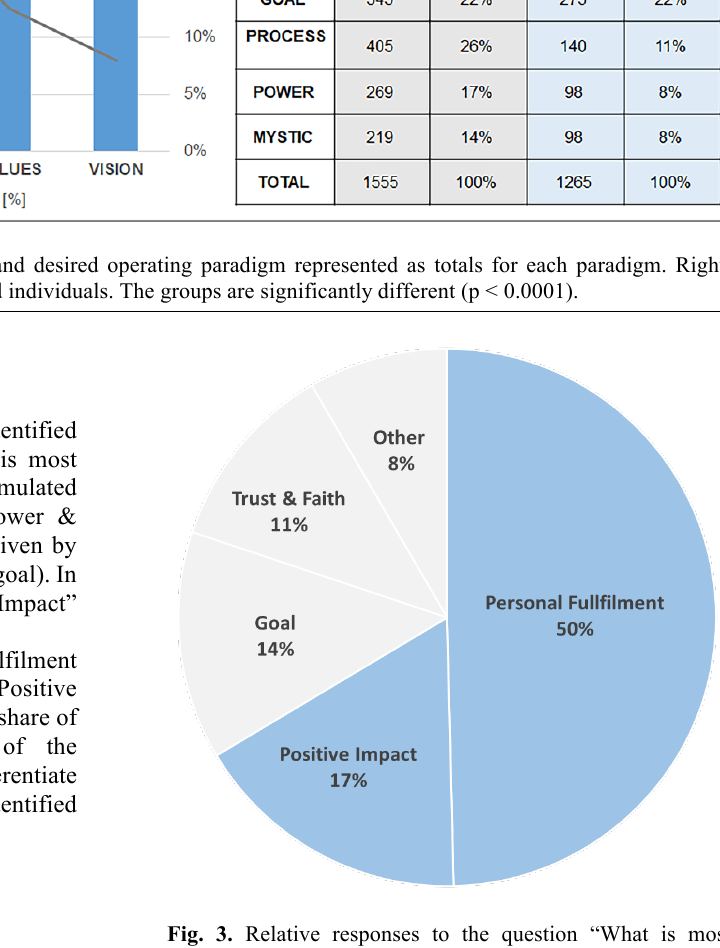
Fig. 3. Relative responses to the question “What is most important to